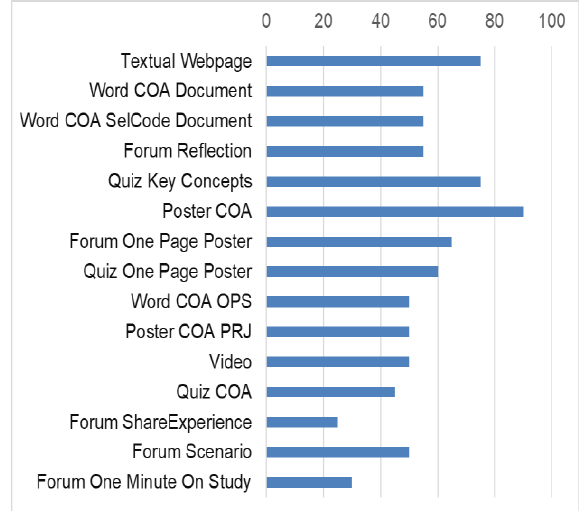
Figure 3 : Percentage of Participants accessed e- learning resources